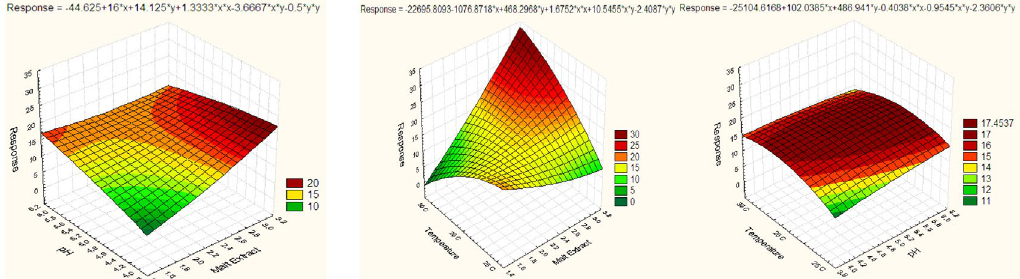
Fig. 6. Response surface plots displaying effect and interaction of variables on diameter of inhibition zones constructed on the results of Box-Behnken design.